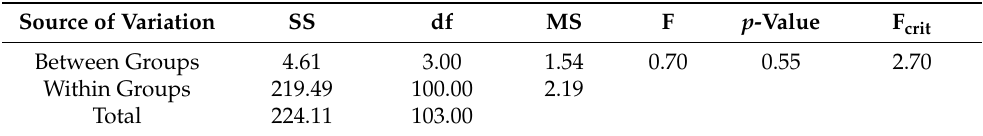
Table 9. ANOVA for BW for the 1.5 mm thick samples welded with and without nitrogen in the shielding